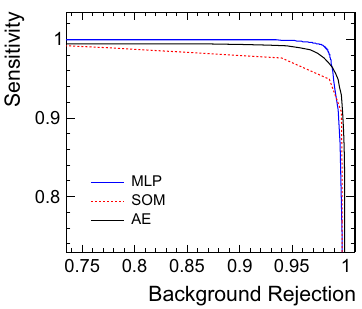
Fig. 6 ROC curves for the three machine learning algorithms: a super- vised MLP – Multilayer Perceptron, an unsupervised SOM – Self- Organizing Map and an unsupervised AE – Autoencoder